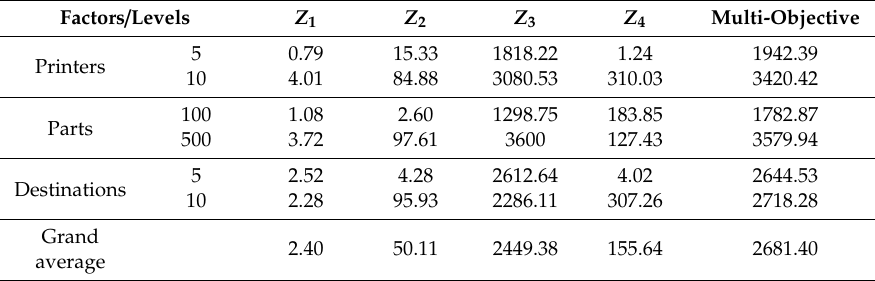
Table 6. Aggregated computation time for a designed experiment